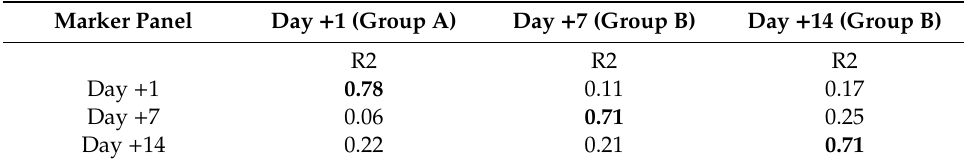
Table A3. Applicability of marker panels at individual time